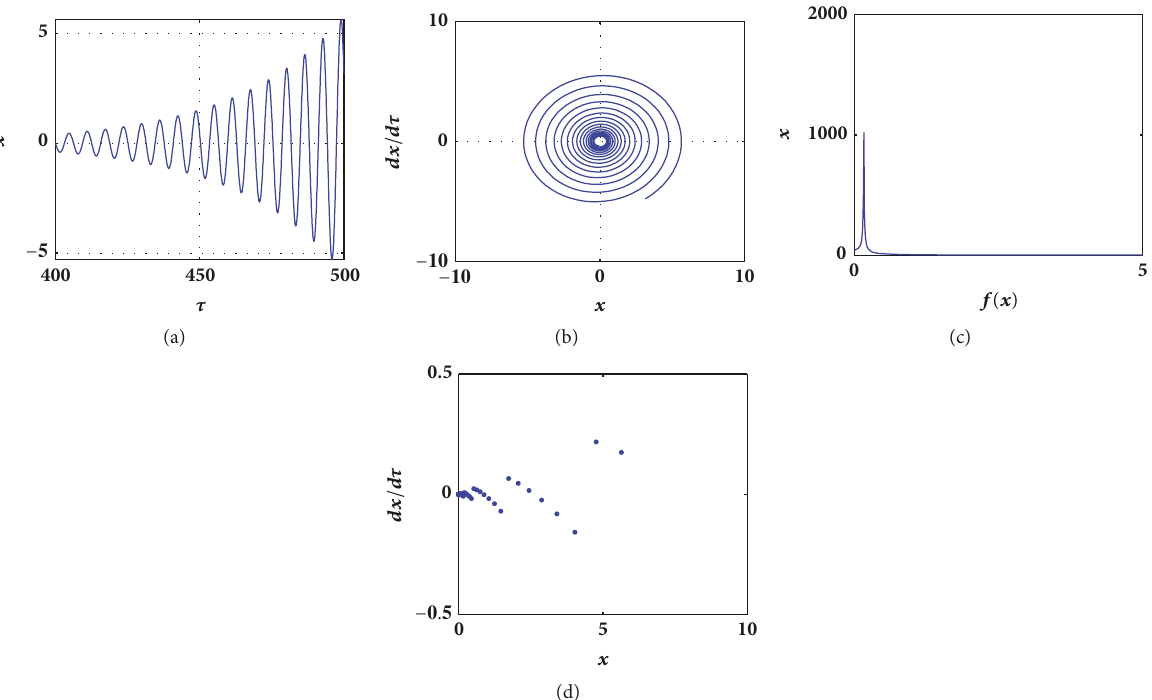
Figure 8: The time history, the phase diagram, spectrum, and the Poincar´e section of the system (6) for 𝜀 = 0.05385 , 𝑄 = −1